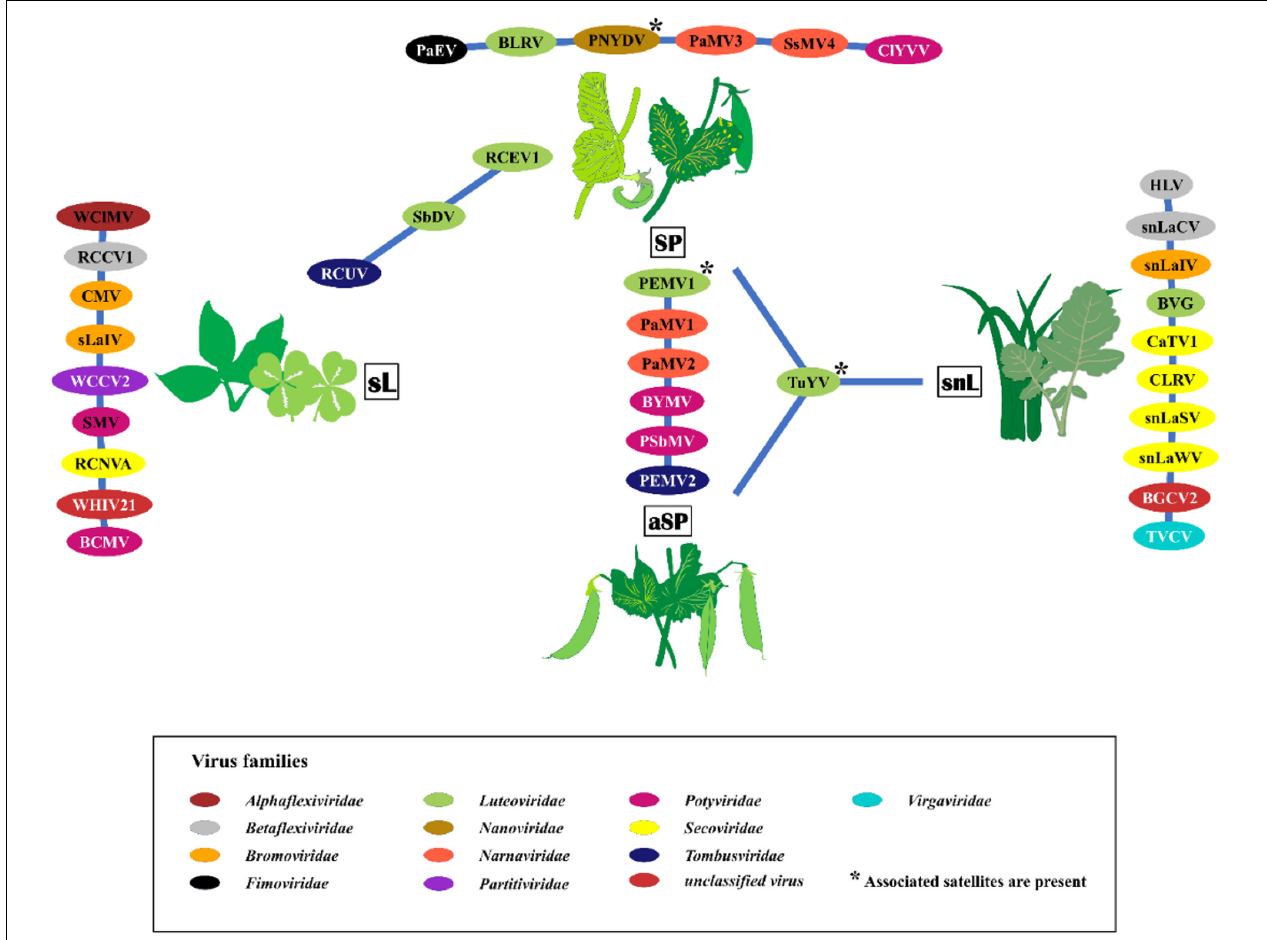
FIGURE 2 | The virus species found in the four sampling categories symptomatic peas (SP), asymptomatic peas (aSP), surrounding legumes (sL), and surrounding non-legumes (snL). Samples were collected in six pea-growing regions (Salzlandkreis-1, Salzlandkreis-2, Münster, Kreis Stormarn, Landkreis Rostock, and Landkreis Meißen) in Germany over three successive seasons 2016, 2017, and 2018. A network illustration of virus species of each category and shared viruses among them. Background colors of virus acronyms correspond to the background colors of the respective virus family. The virus names are: BVG, barley virus G; BCMV, bean common mosaic virus; BLRV, bean leafroll virus; BYMV, bean yellow mosaic virus; BGCV2, black grass cryptic virus 2; CaTV1, carrot torradovirus 1; CLRV, cherry leaf roll virus; ClYVV, clover yellow vein virus; CMV, cucumber mosaic virus; HLV, Heracleum latent virus; PaMV1, pea associated mitovirus 1; PaMV2, pea associated mitovirus 2; PaMV3, pea associated mitovirus 3; PaEV, pea associated emaravirus; PEMV1, pea enation mosaic virus 1; PEMV2, pea enation mosaic virus 2; PNYDV, pea necrotic yellow dwarf virus; PSbMV, pea seed-borne mosaic virus; RCCV1, red clover carlavirus 1; RCEV1, red clover enamovirus 1; RCNVA, red clover nepovirus a; RCUV, red clover umbravirus; SsMV4, Sclerotinia sclerotiorum mitovirus 4; sLaIV, sL associated ilarvirus; snLaCV, snL associated chordovirus; snLaIV, snL associated ilarvirus; snLaSV, snL associated secoviridae; snLaWV, snL associated waikavirus; SbDV, soybean dwarf virus; SMV, soybean mosaic virus; TVCV, turnip vein-clearing virus; TuYV, turnip yellows virus; WCCV2, white clover cryptic virus 2; WClMV, white clover mosaic virus; WHIV21, Wuhan insect virus